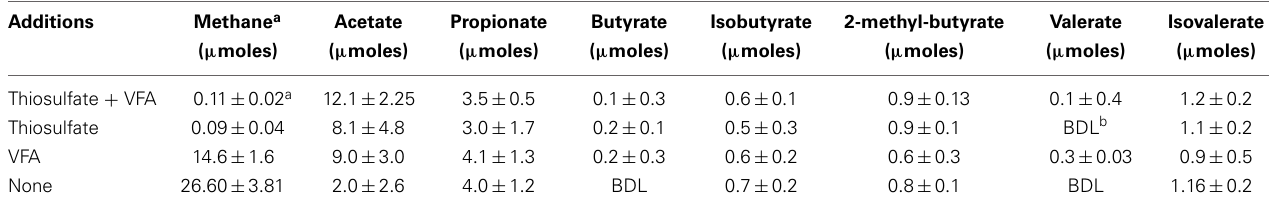
Table 2 | Net production of methane and volatile fatty acids by enrichments transferred four times in medium (containing 0.05% yeast extract) with and without thiosulfate and volatile fatty